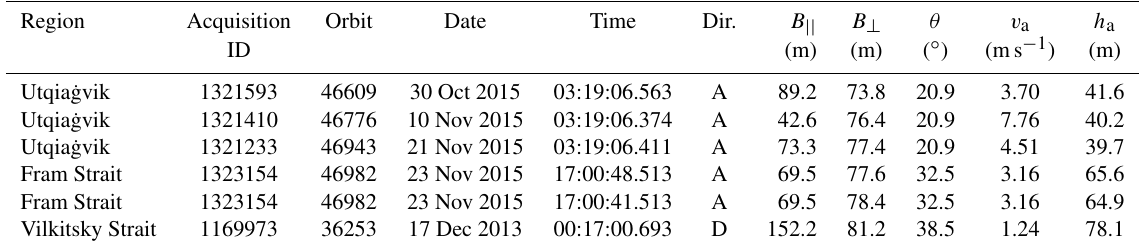
Table 1. List of TanDEM-X datasets analyzed. Region